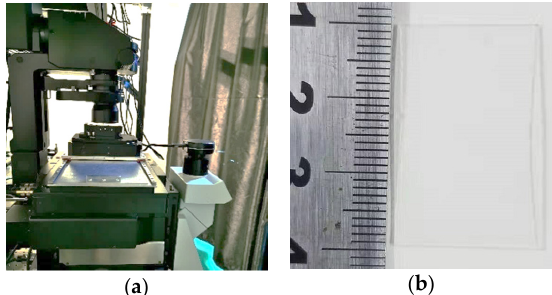
Figure 2. Parameter configuration: r being the curvature radius of the upper surface of the convex spiral phaser and D the diameter of the bottom circle and H the height of the cut surface and d the height of the base.